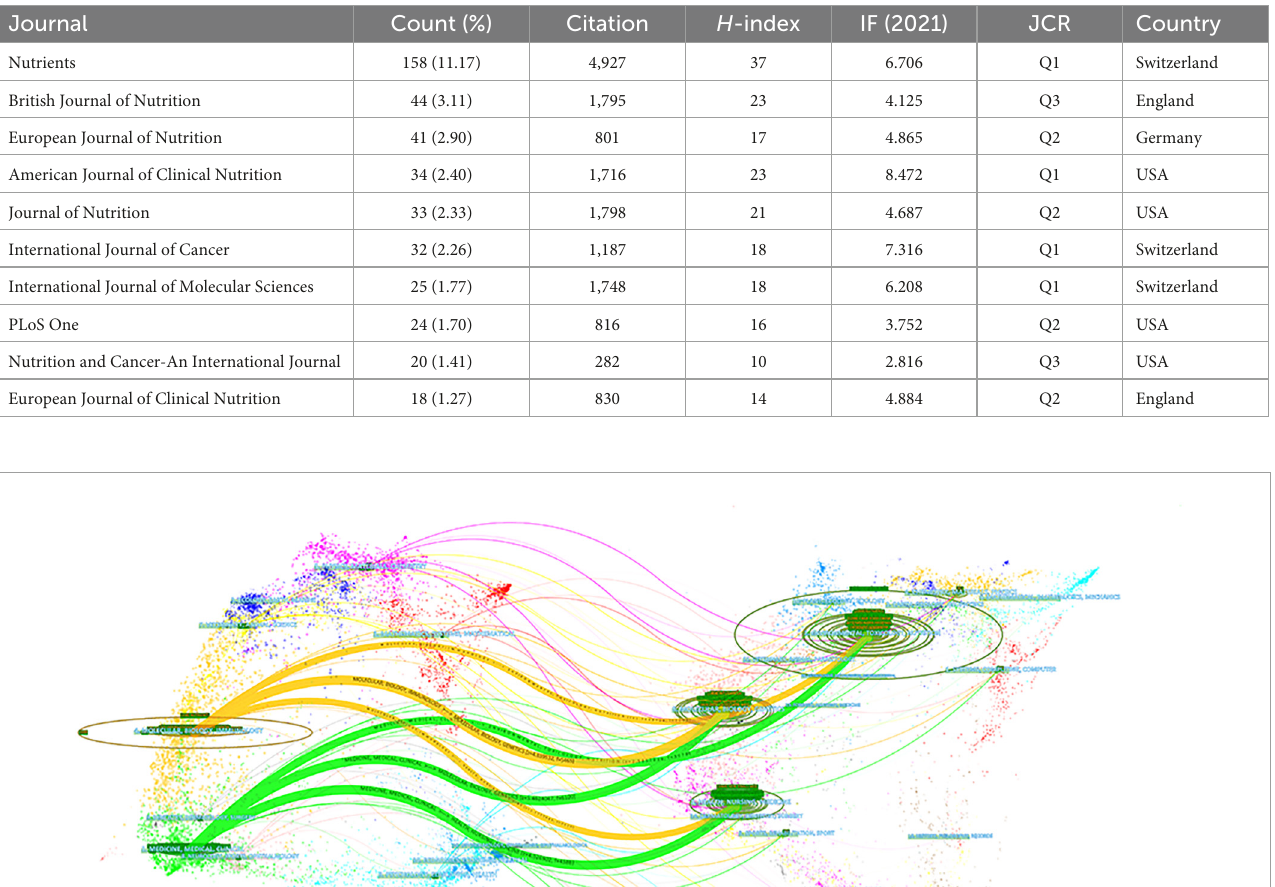
TABLE 2 Top 10 productive journals related to the Mediterranean diet (MD) on cancer.